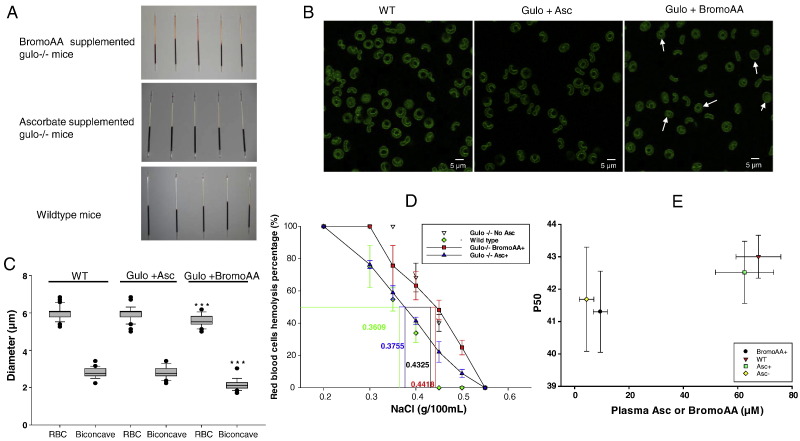
Characteristics of red blood cells (RBCs) obtained from gulo−/− mice supplemented with bromoAA for 15 weeks. A. Centrifugation of mouse whole blood from unsupplemented wild type mice; gulo−/− mice supplemented daily with 1 g/L bromoAA for 15 weeks; or gulo−/− mice supplemented daily with 1 g/L ascorbate for 15 weeks. B. Confocal microscopy of RBCs from unsupplemented wild type mice and gulo−/− mice supplemented with ascorbate or bromoAA. The ascorbate and bromoAA concentrations in plasma and RBCs were the same as shown in Fig. 3A. Examples of swollen RBCs are indicated by arrows. C. RBC and biconcave diameters of samples from wild type mice, gulo−/− mice supplemented with ascorbate, or gulo−/− mice supplemented with bromoAA. Thirty mouse RBCs in full view orientation were randomly selected from each group for measurement of cell diameters and biconcave area diameters. The diameters were determined using ZEN 2007 software (Carl Zeiss, Inc.) by drawing a horizontal line through the center of each target RBC and calculating the distances between two points where fluorescent intensities were most different (Tu et al., 2015). N = 30 RBC per point. *** P < 0.001. The ascorbate and bromoAA concentrations in plasma and RBCs were the same as shown in Fig. 3A. D. Osmotic fragility in mouse RBCs as a function of NaCl concentration. RBC samples were obtained from unsupplemented wild type mice; gulo−/− mice supplemented with ascorbate or bromoAA for 15 weeks, and ascorbate depleted gulo−/− mice. Ascorbate depleted mice were supplemented by gavage with 0.2 mg of ascorbate in 100 μL water once at 6 weeks. Gavage was performed to maintain mice at low ascorbate values while preventing demise from scurvy. N = 5 mice (starting from 18 weeks old) per point. The 50% lysis point for each condition (horizontal line) is determined by the vertical line of the same color. Statistics (two-tailed t-test) for 50% lysis: p < 0.001 for wildtype vs unsupplemented gulo−/− mice, wildtype vs bromoAA gulo−/− mice; p < 0.05 for unsupplemented vs ascorbate supplemented gulo−/− mice, bromoAA vs ascorbate supplemented gulo−/− mice. There were no statistical differences (p > 0.105) between wildtype and ascorbate supplemented gulo−/− mice and unsupplemented vs bromoAA supplemented gulo−/− mice. E. Oxygen dissociation (P50) values of RBCs from unsupplemented wild type mice (N = 5), gulo−/− mice supplemented with ascorbate (N = 5) or bromoAA (N = 6), and ascorbate depleted gulo−/− mice (N = 5). P = 0.12 for all groups (one way ANOVA); p = 0.04 for WT vs bromoAA (t-test).